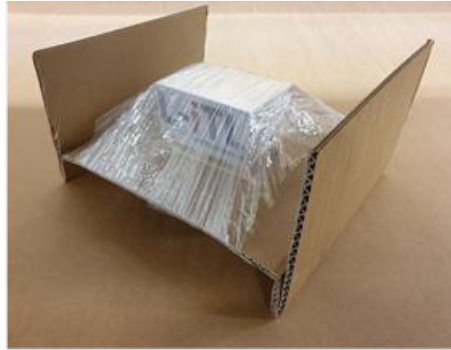
Figure 2: General purpose suspension